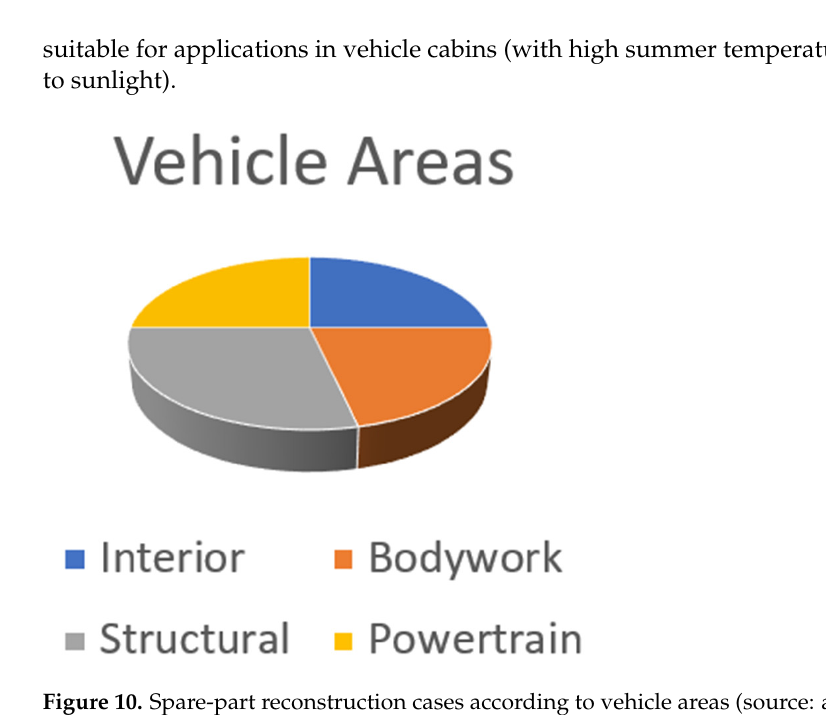
Figure 10. Spare-part reconstruction cases according to vehicle areas (source: authors’ elaboration based on the literature review).